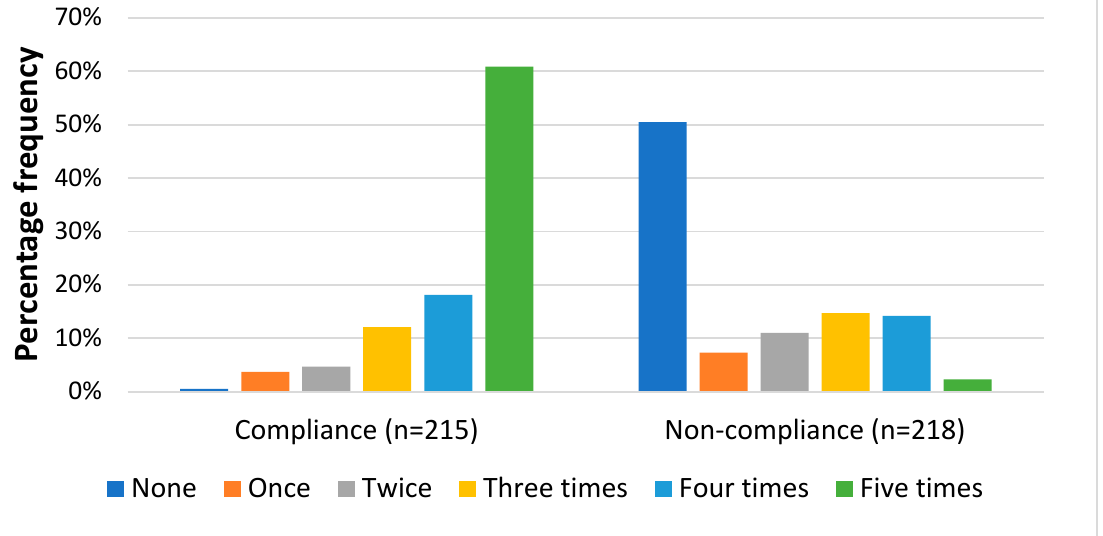
Figure 2. Number of times respondents reported taking the MDA drugs during the last five MDA rounds .